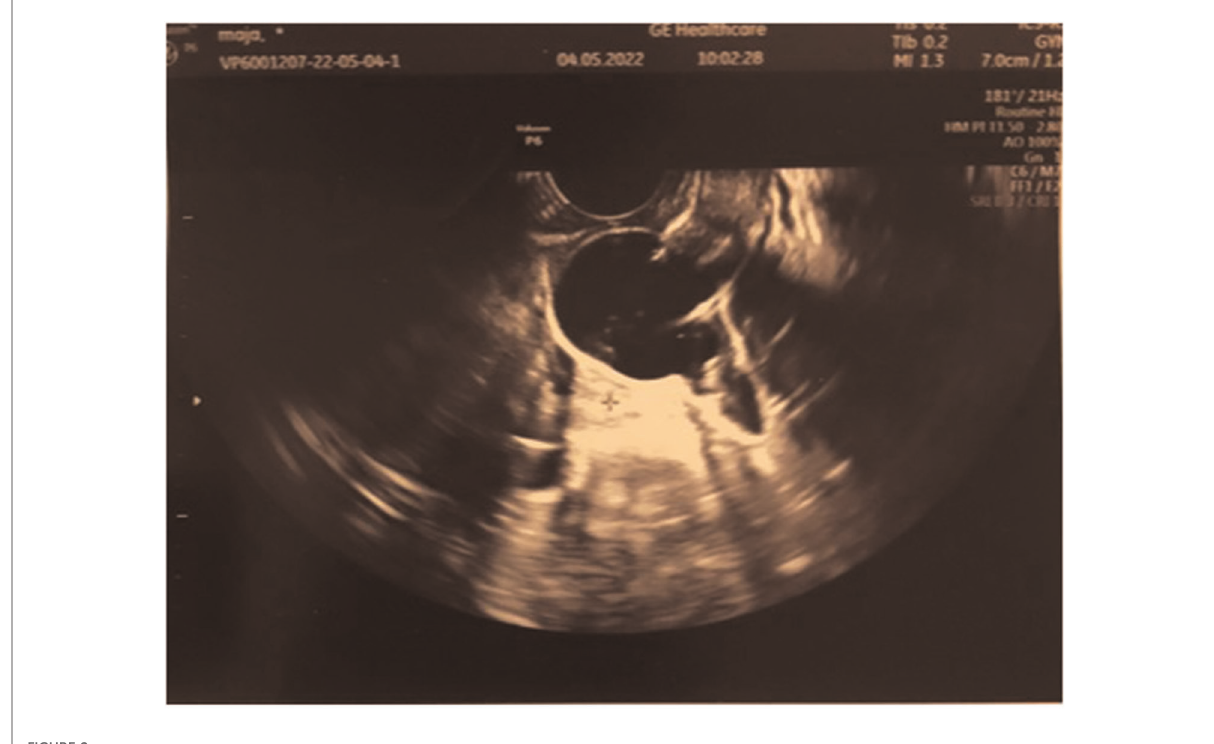
FIGURE 2 Intraoperative transrectal sonography presents hematocolpos.